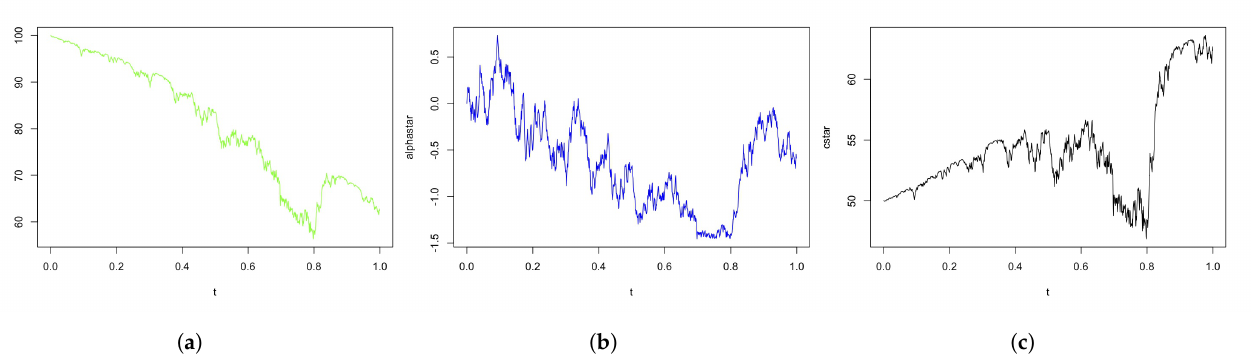
. ( c ) Optimal consumption c ∗ t